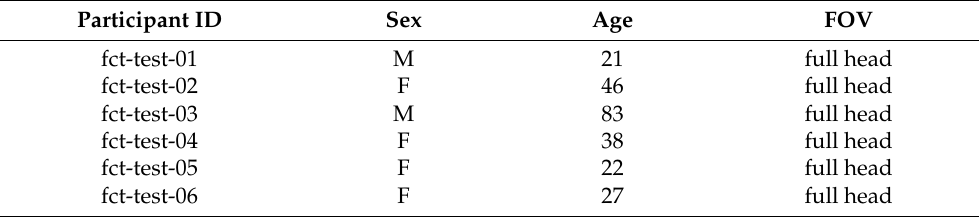
Figure 3. Representative MR-CT pairs from the validation dataset showing ( a – c ) full head and neck MRs and ( d – f ) their corresponding full head and neck CT images. Table 2. Demographic and technical details from patients included in the validation